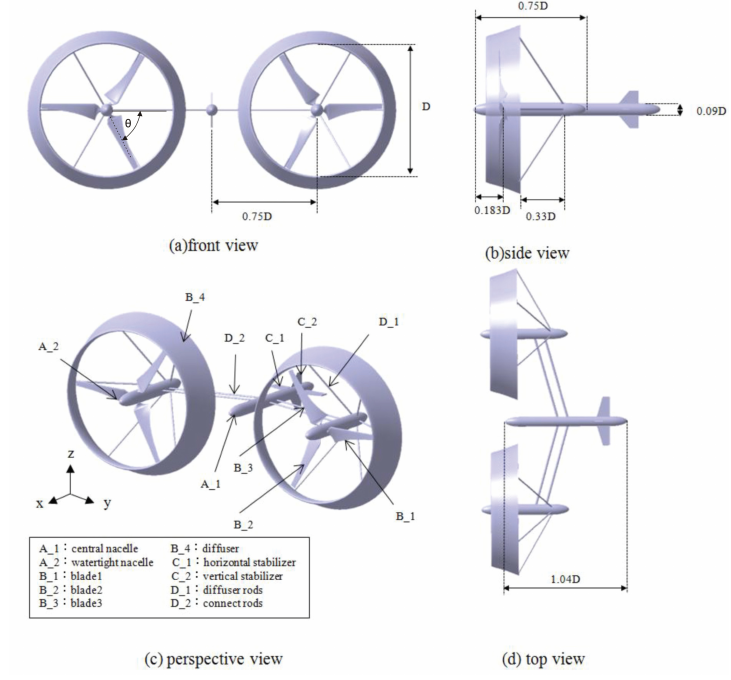
Figure 1. The schematic of the turbine. D, the rotor diameter, = 24 m. ( a ) front view; ( b ) side view; ( c ) perspective view; ( d ) top